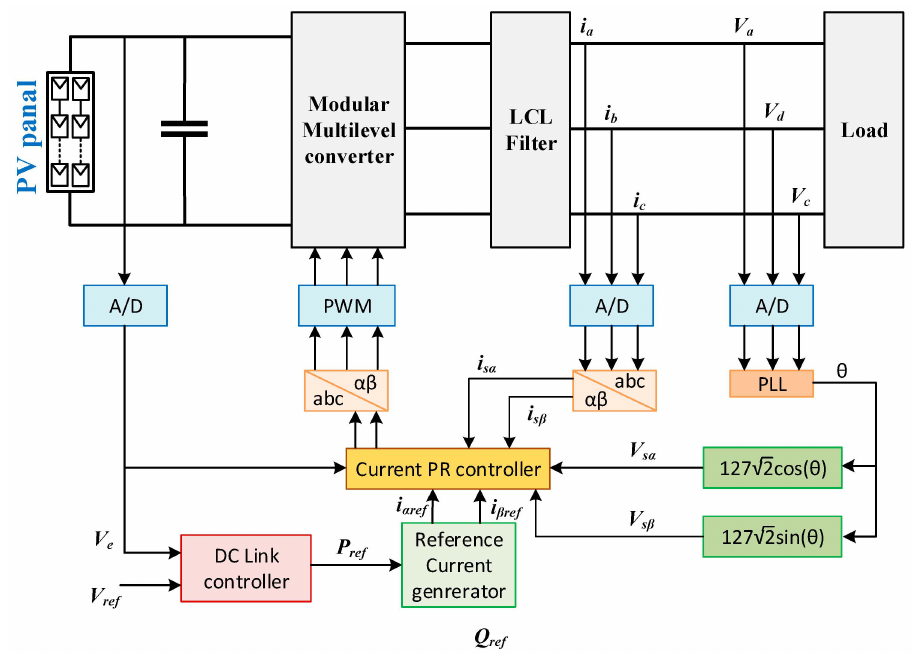
Figure 21. Control of MMC with PR controller